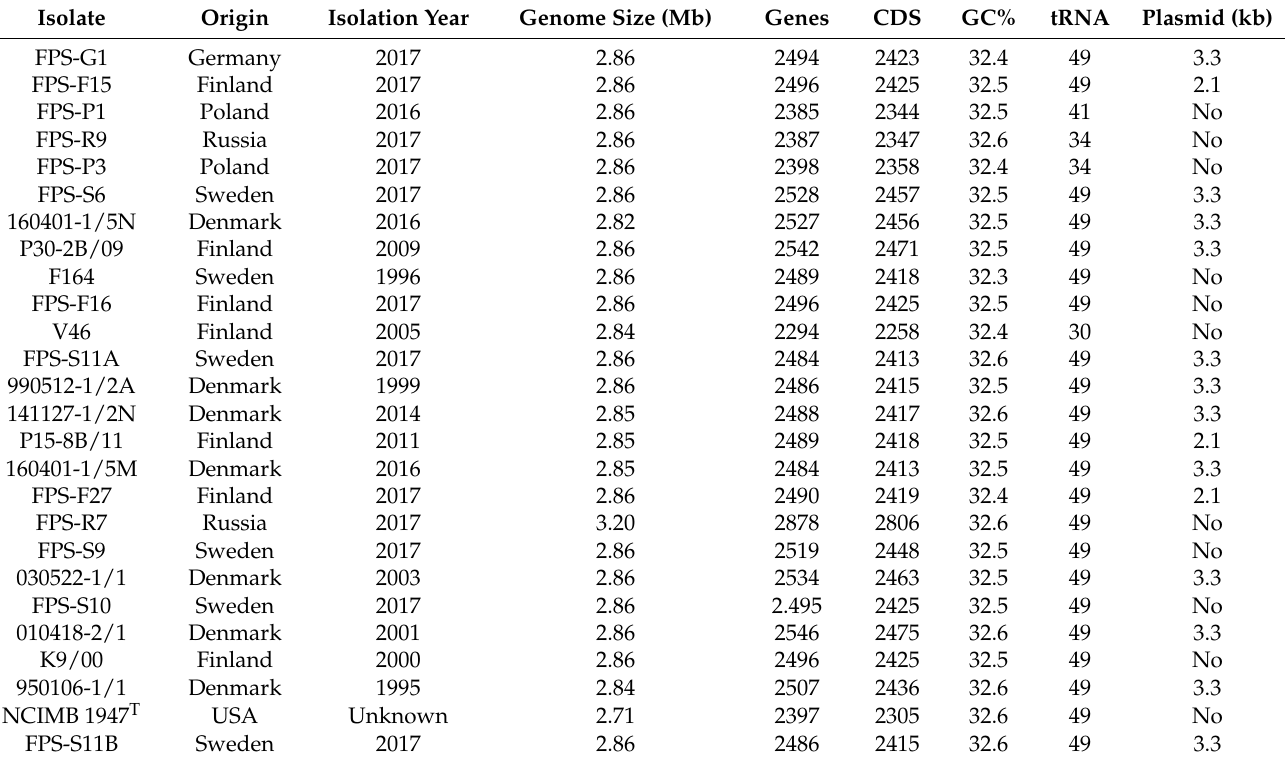
Table 1. Genomic features of F. psychrophilum isolates used in this